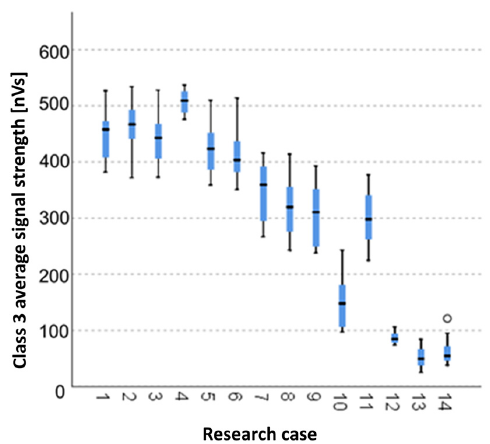
Figure 23. The graphical representation of the Kruskal–Wallis test results for independent samples of the average signal strength of the class 3 signals.